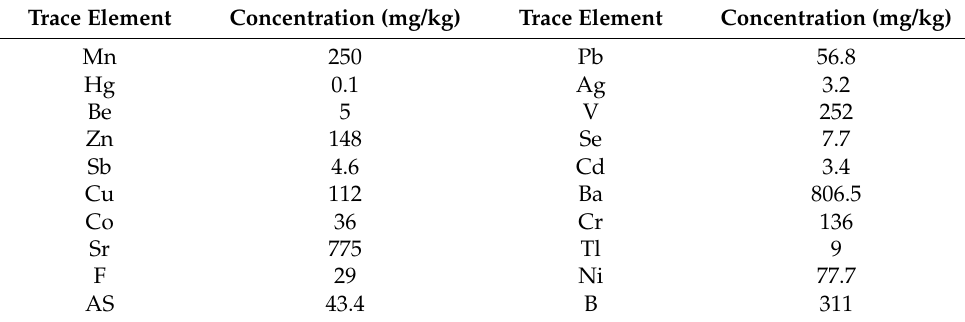
Table 6. Concentrations of trace elements in fly